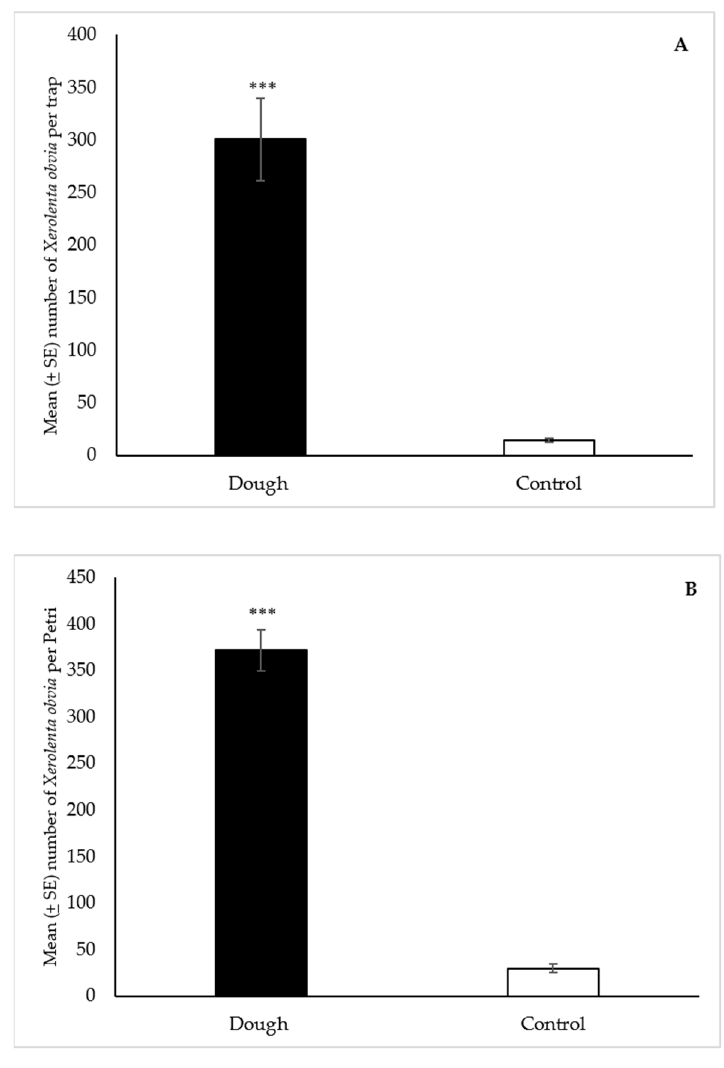
Figure 5. Mean (±SE) number of Xerolenta obvia collected per trap over 48 h in Snailer ® traps ( A ) and Petri dishes ( B ) baited with 2-day aged bread dough or a water control, in field trials near Belt, Montana. Traps also contained liquid metaldehyde at labeled rate. Treatment bars with asterisks indicate significant differences (*** p < 0.001) between the median number of specimens collected in the dough and control traps. Mann Whitney U test: ( A ) standardized test statistic = 7.08, n = 60, p < 0.001; ( B ) standardized test statistic = 6.65, n = 30, p < 0.001.